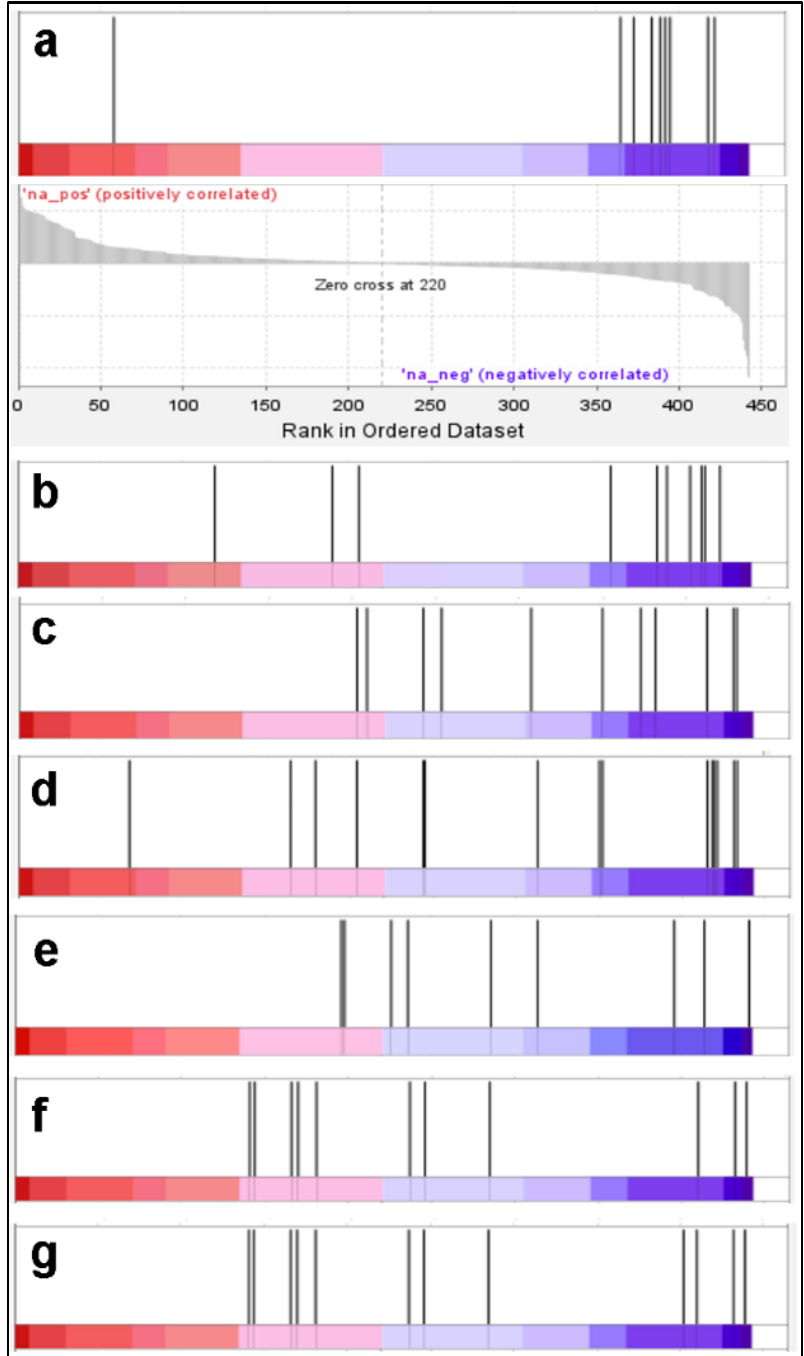
Figure 1. Proteins downregulated in the ALS samples are enriched in proteins of GSEA sets known to be perturbed in ALS: ( a ) the “E2F1_UP.V1_UP” set. The lower histogram shows the ratio in ALS vs. control for each protein differentially present in our samples, ranked from the most upregulated (on the left) to the most downregulated (to the right). The vertical bars in the upper panel show the positions of the proteins from the GSEA set present in the proteomics set; ( b – g ): similar upper histograms for other GSEA pathways enriched in ALS differentially expressed proteins; ( b ) “Rutella response to HGF_DN” (genes induced by HGF); ( c ) “KEGG spliceosome”; ( d ) “module 183 cancer RNA splicing”; ( e ) “QI_Hypoxia”, (HIF-induced genes); ( f ) “GOBP positive regulation of protein localization to nucleus”; ( g ) “GOBP regulation of protein localization to